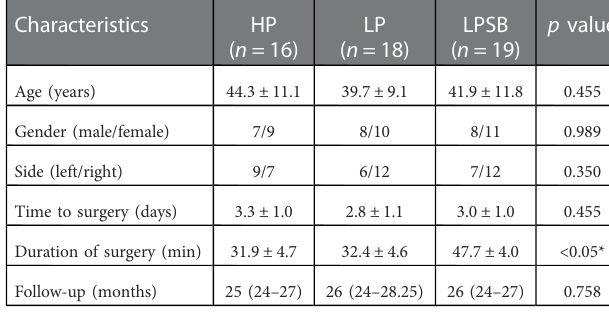
TABLE 1 Baseline characteristics of the three groups.